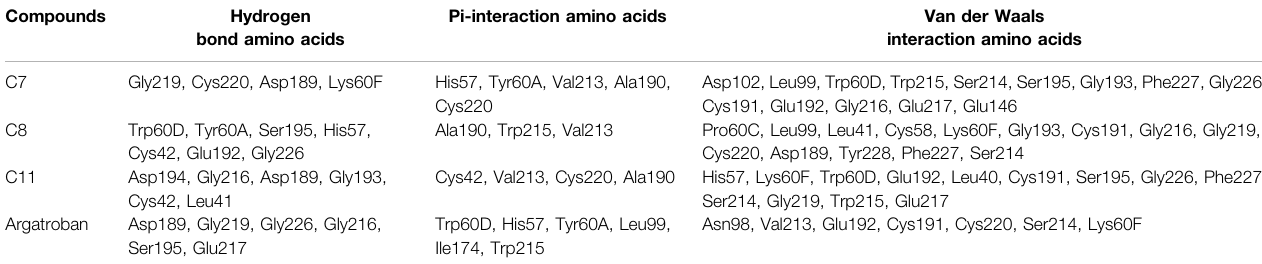
TABLE 2 | Binding sites of the compounds and the interaction forces between monomer and